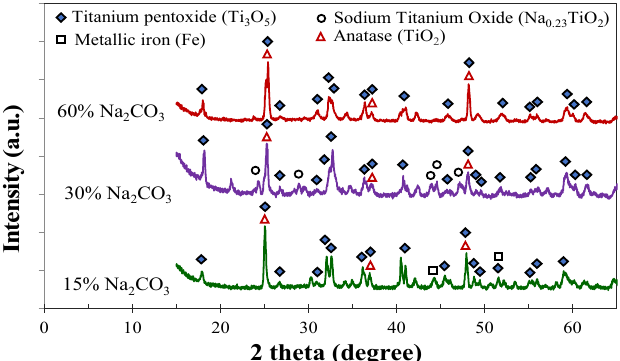
Figure 10. XRD spectra of slag after metal granules separation from the carbothermic reduction of the ilmenite concentrate at initial temperature of 1300 ◦ C, final temperatures of 1500 ◦ C, and heating rate of 6.6 ◦ C/min (pattern G).